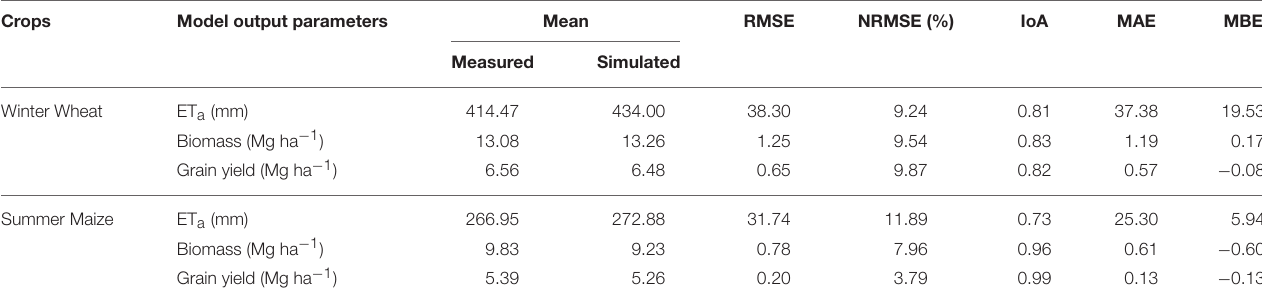
TABLE 6 | Simulation error statistics of winter wheat and summer maize. Crops Model output